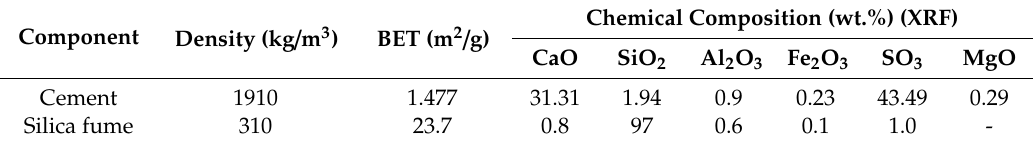
Table 2. The chemical composition and geometric characteristics of cement and silica